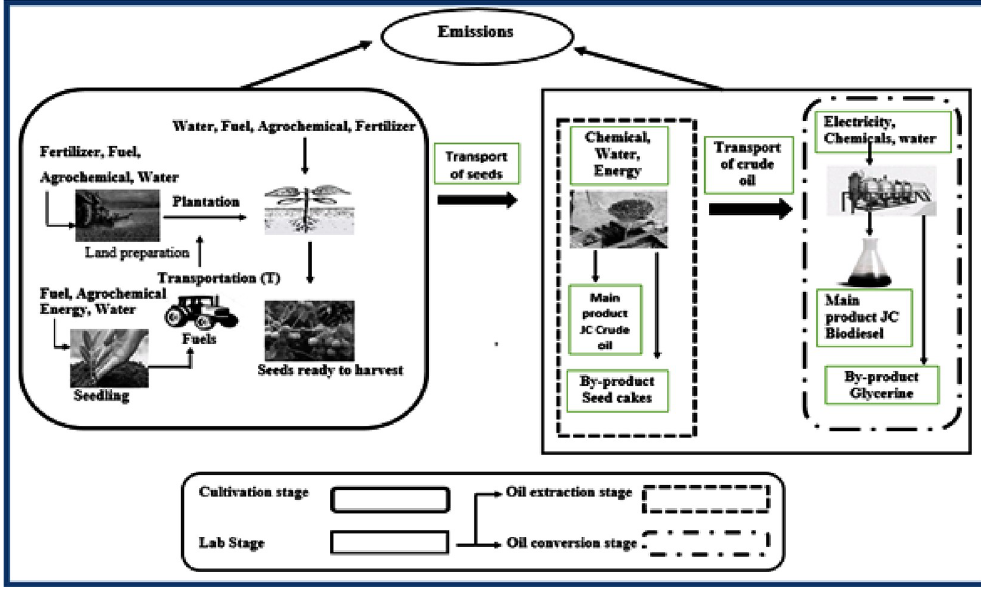
Fig 1. System boundary of the